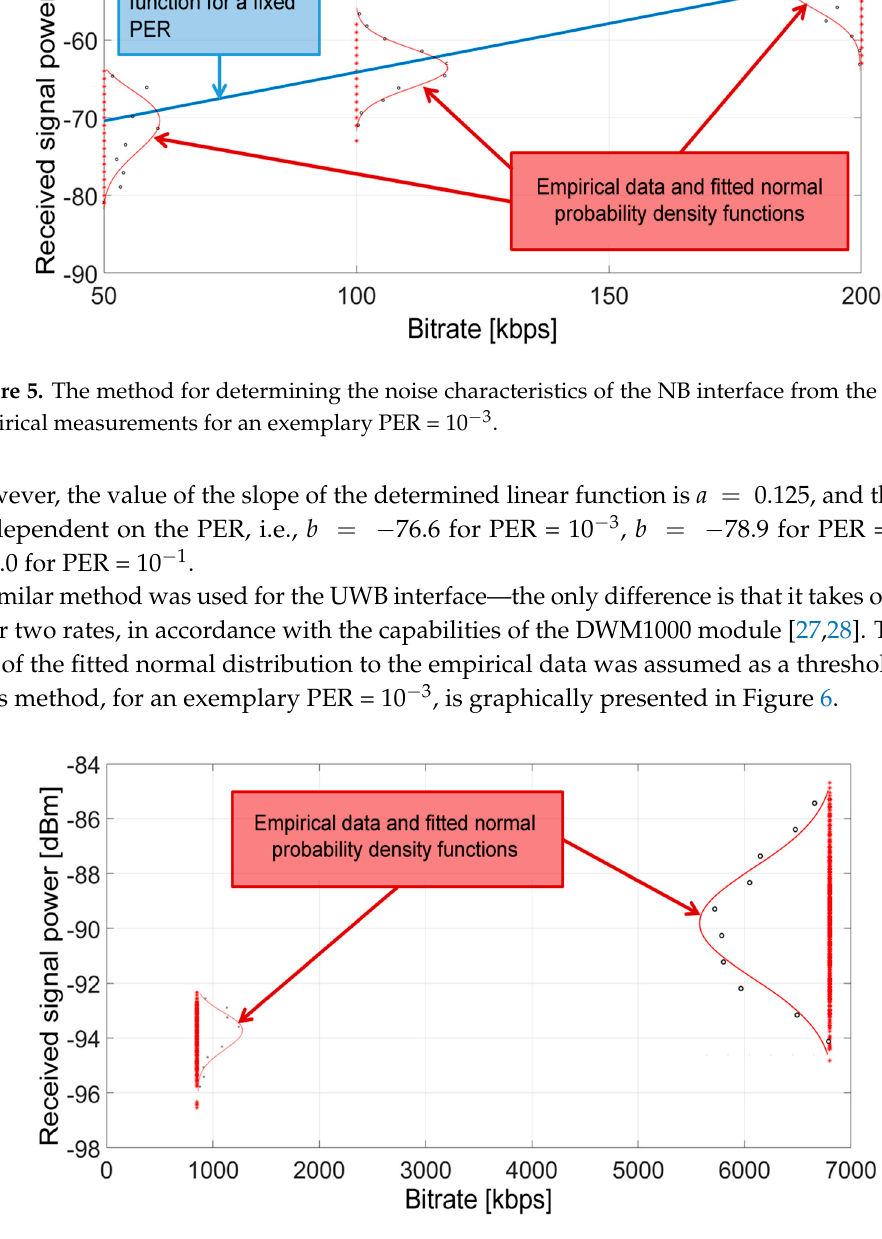
Figure 6. The method for determining the noise characteristics of the UWB interface from the data of empirical measurements for an exemplary packet error rate (PER) = 10 − 3 .